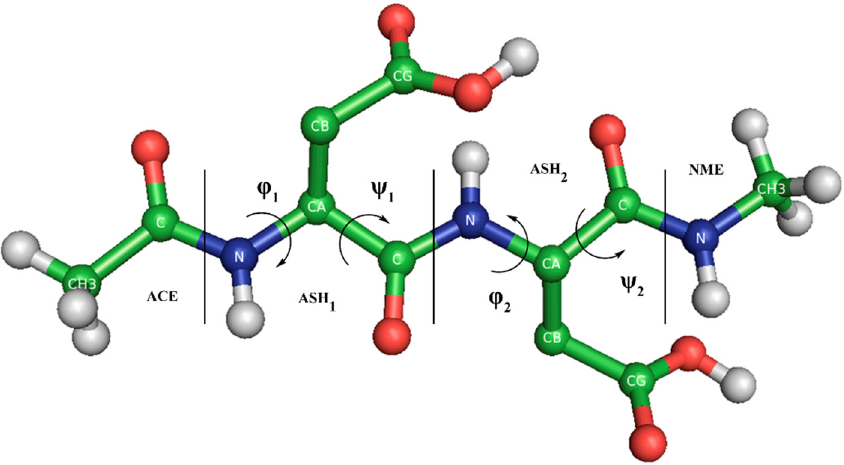
Figure 1. Blocked Asp 2 tripeptide in the syn-O2 protonated state. Amino acids, capping groups, and ϕ and ψ dihedral angles are indicated. The θ angle is constructed by the CG 1 , CA 1 , CA 2 , and CG 2 atoms. Nonpolar hydrogens of the amino acids are hidden. Subscripts refer to monomer 1 and 2.